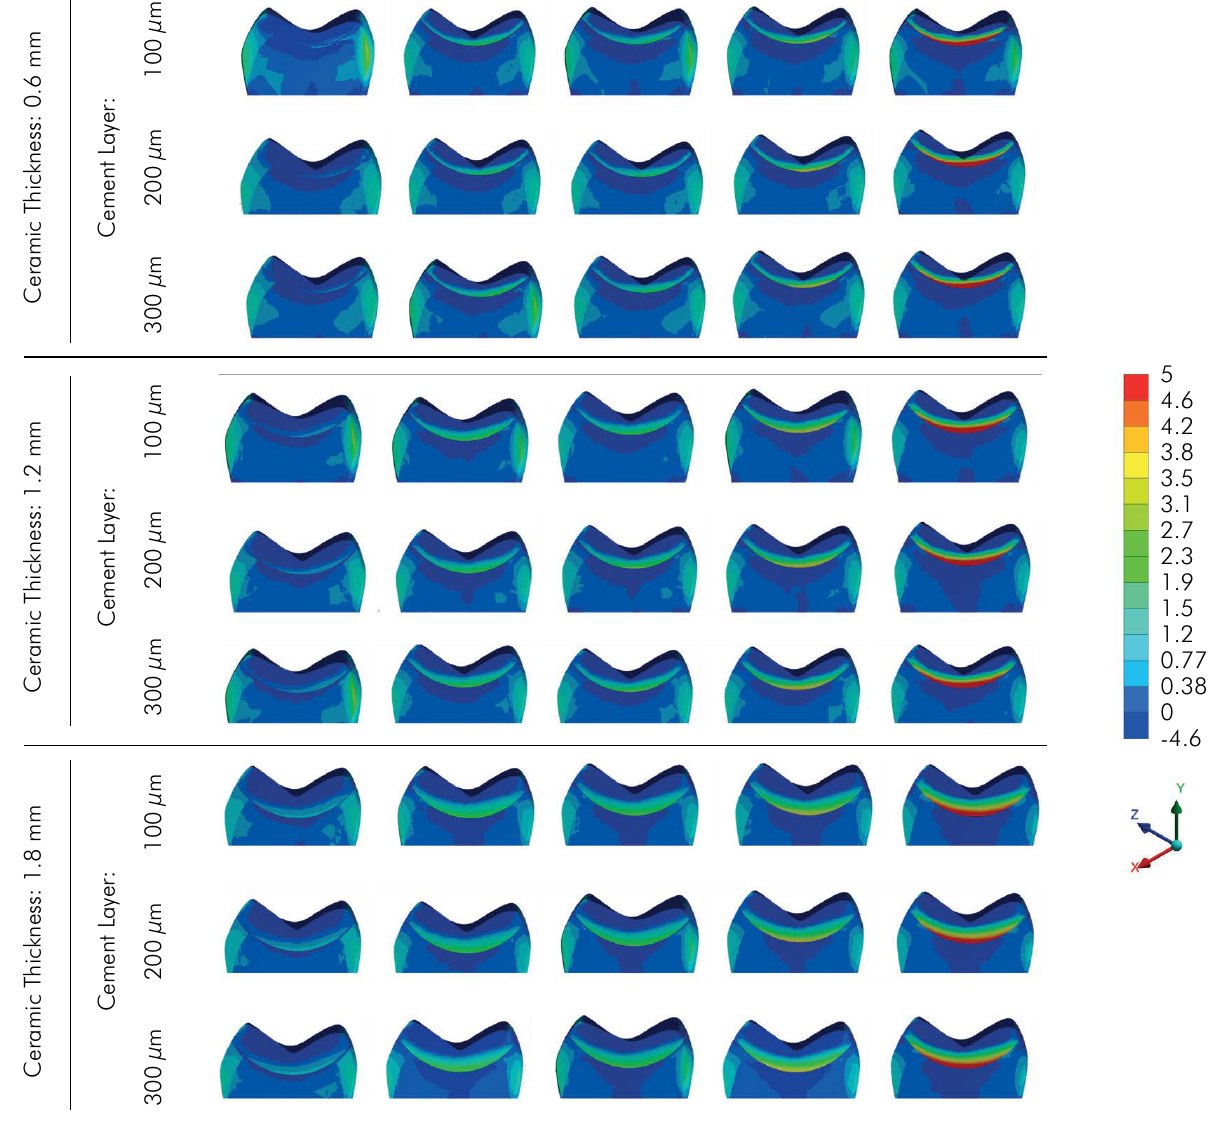
Figure 3. Tensile stress in teeth restored with occlusal veneers in sagittal